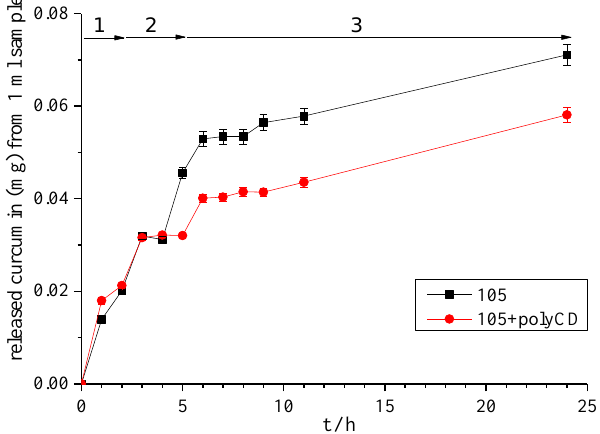
Figure 9. Amount of released curcumin from the Pluronic 105 micellar system and its stabilized form by poly-β-CD (Model fluids: 1 simulated gastric fluid, 2 simulated intestinal fluid, 3 colonic fluid).